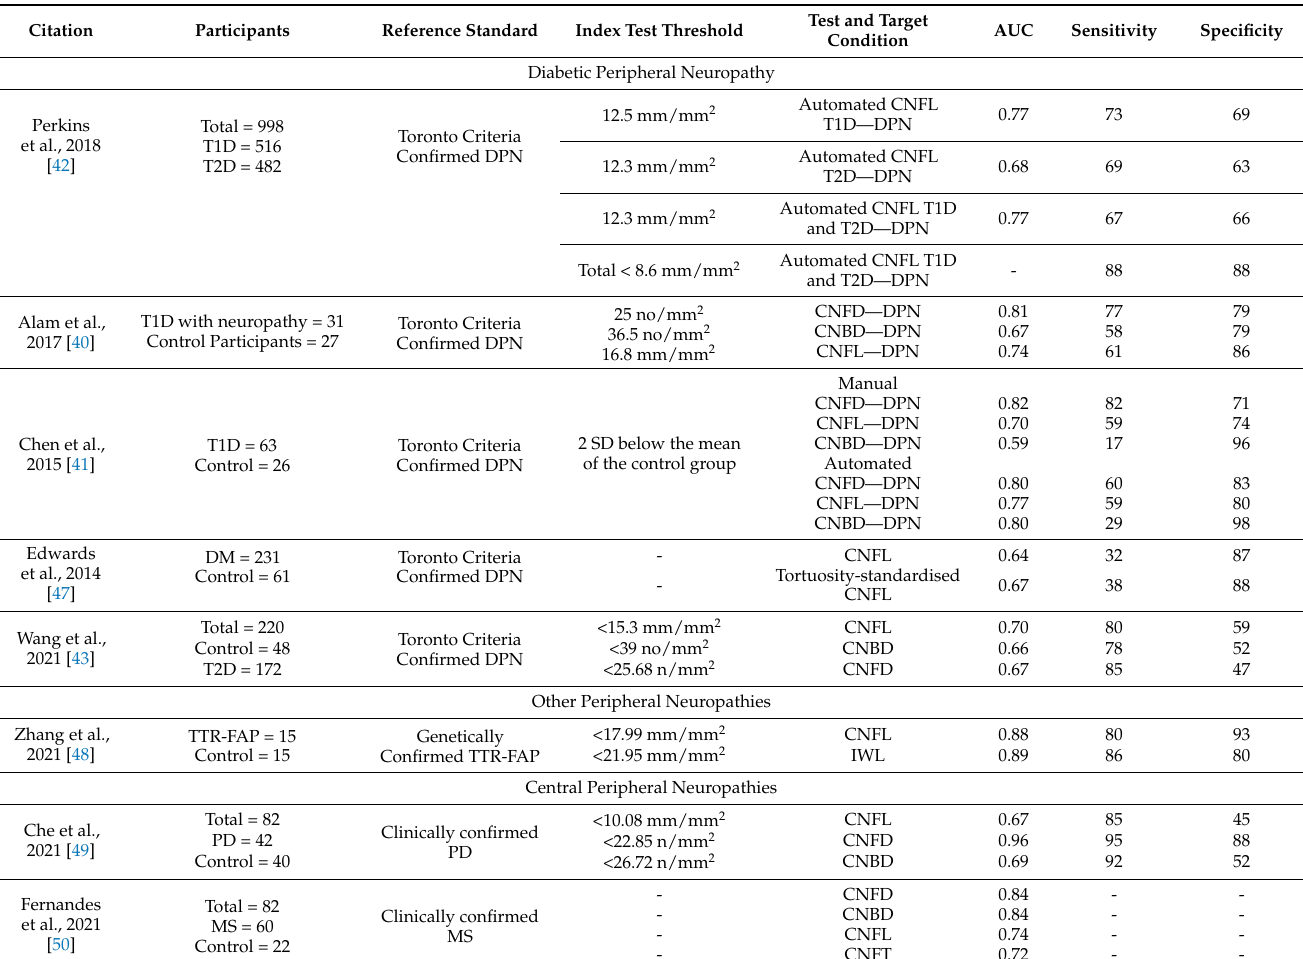
Table 1. Manual and automated approaches using corneal confocal microscopy images to classify